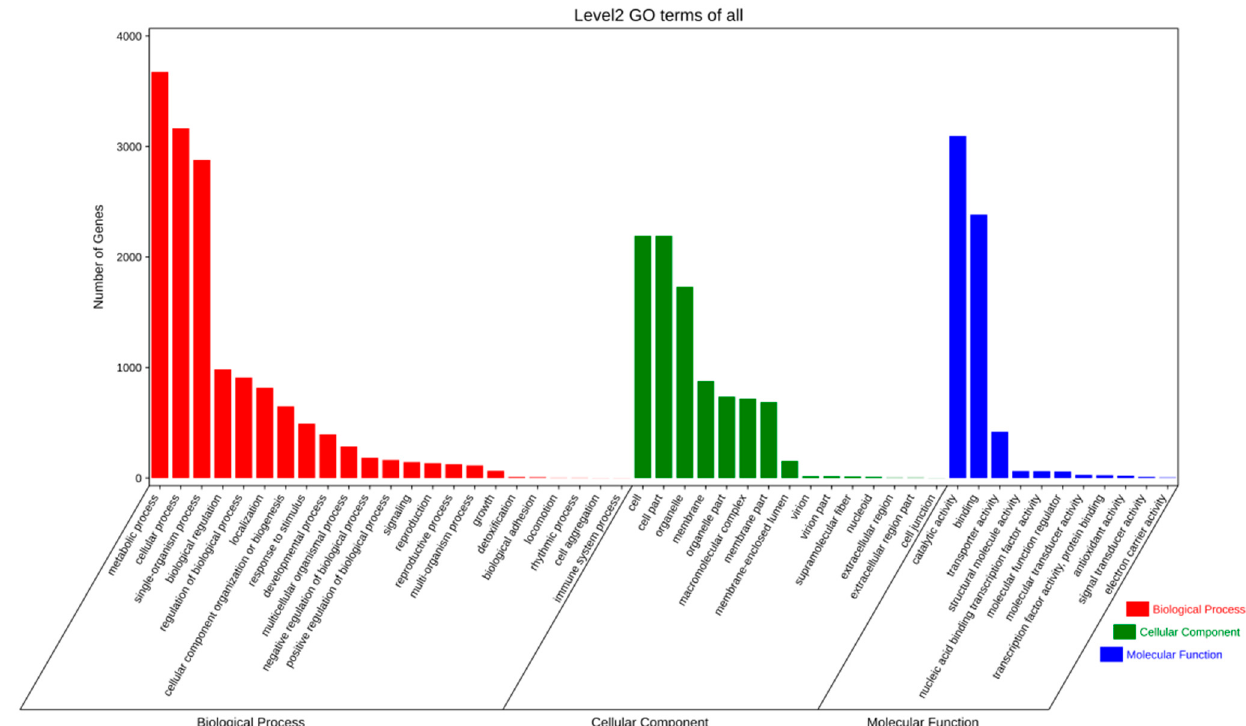
Figure 5. GO functional annotation of strain QK8.